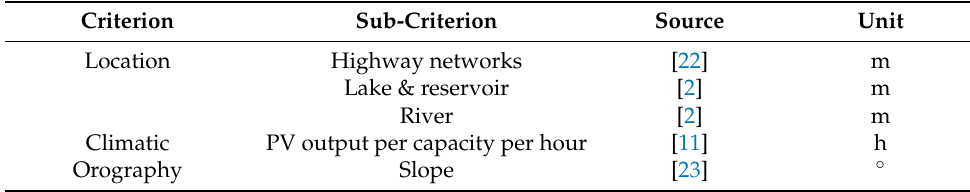
Table 1. Description of data used for site selection.